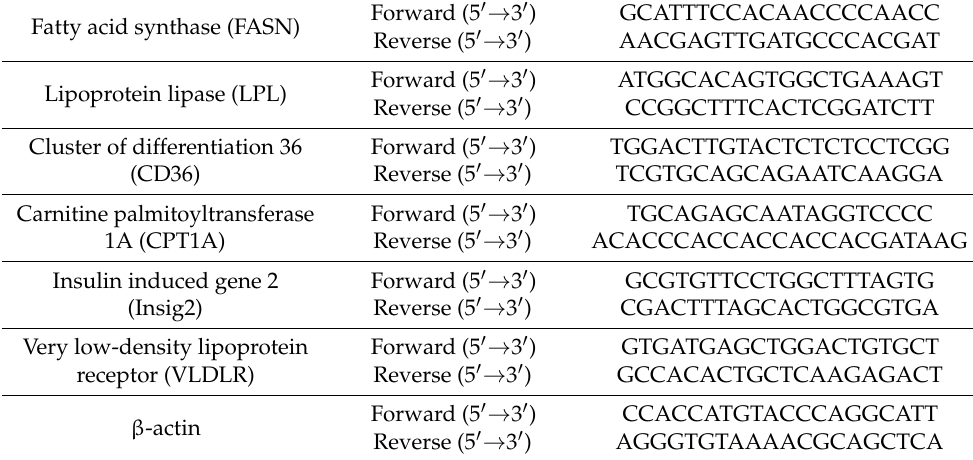
Table 1. The sequence primers for quantitative